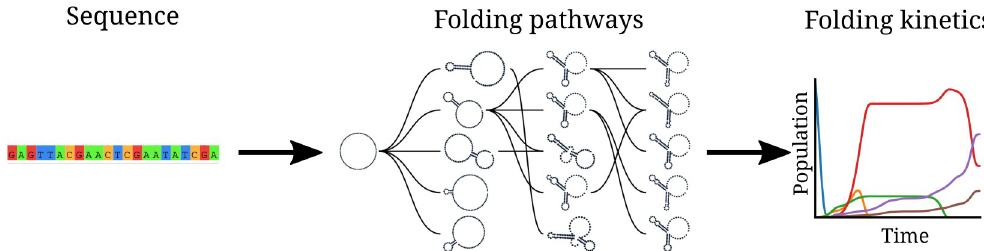
Fig 1. RAFFT framework. (1) The sequence of nucleotides of the RNA molecule is first encoded numerically to facilitate its treatment. (2) The numerically encoded sequence is analyzed using the FFT to detect stems quickly, such that stems are added iteratively to form parallel folding paths. (3) The folding pathways form a graph that connects potential intermediate secondary structures. Starting with the unfolded structure, our kinetic ansatz predicts a complete folding trajectory ( i.e . when the RNA molecule adopts a specific